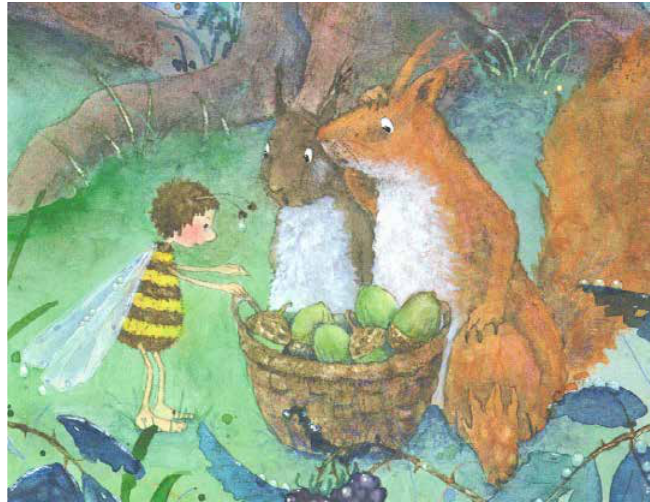
Figure 1: Illustration for the content ‘operating with quantities’: The